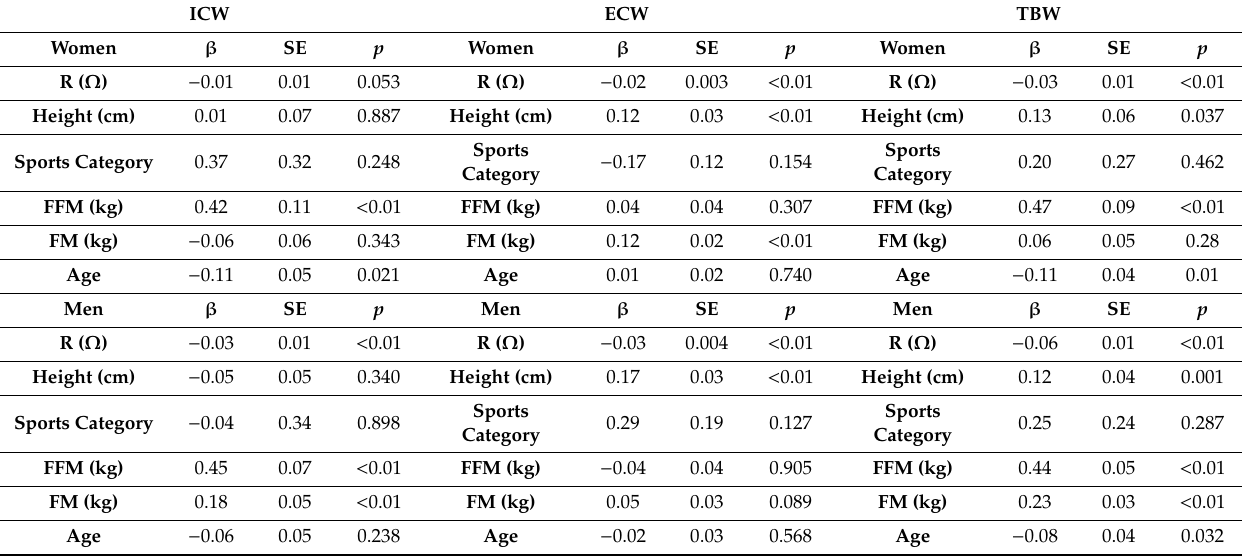
Table 4. Multiple regression analysis between R and ICW, ECW and